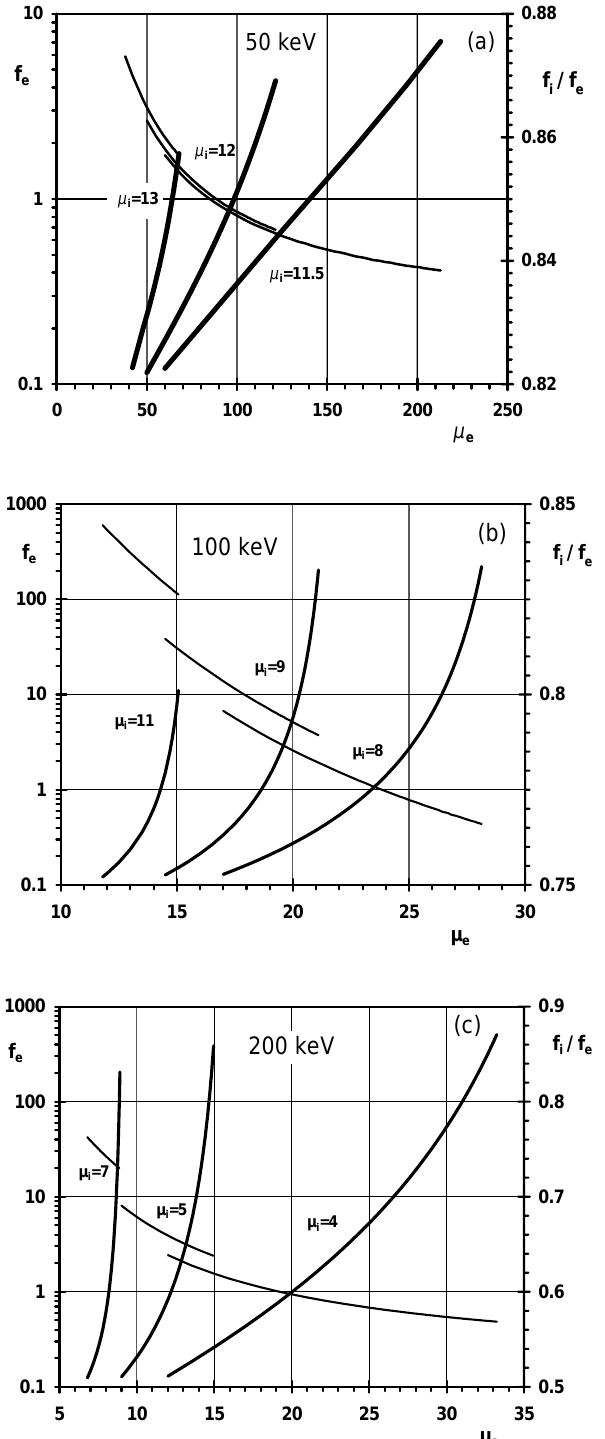
FIG. 3. Variation of the central electron compression f e (thick lines) and of the central degree of neutralization f i (cid:3) f e (thin lines), as functions of the parameters m e and m i for beam energies of (a) 50 keV, (b) 100 keV, and (c) 200 keV. For colder beams (increasing m e ), higher compression at lower cen- tral neutralization becomes possible. At lower energies, where the pinching is less effective, colder electrons and ions are re- quired to obtain self-consistent solutions.